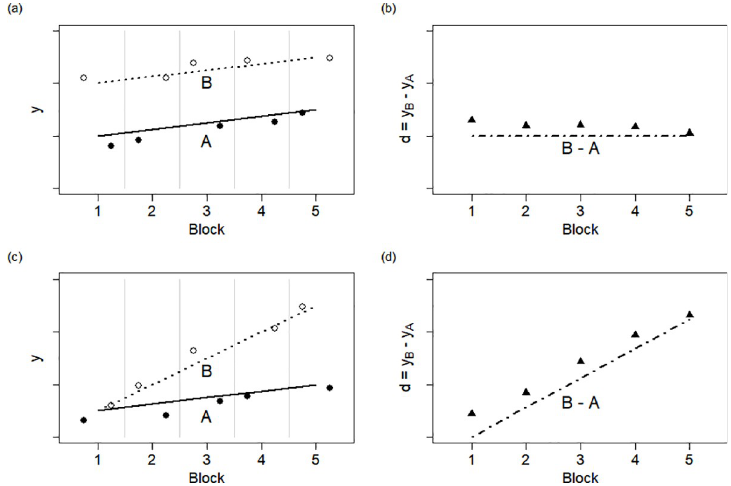
Fig 1. These simulated data represent N -of-1 trials with m crossovers of treatments A and B, randomized within block (left panels). The differences between A and B within a block (right panels) may be suitably analyzed with paired serial t -tests for level-change (top panels) and for rate-change (bottom panels). The true means are represented with lines, and serially correlated observations with points.